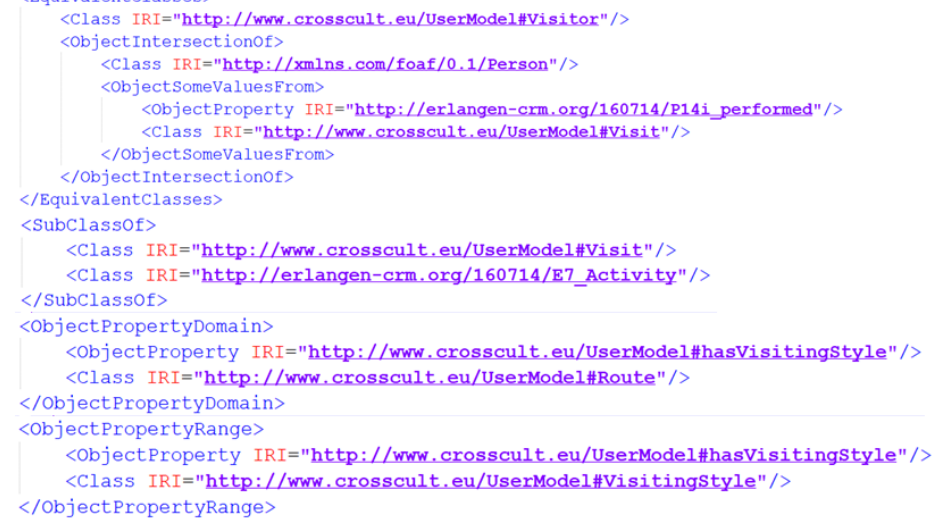
Figure 6. Linking of visitors, visits, and visiting styles.